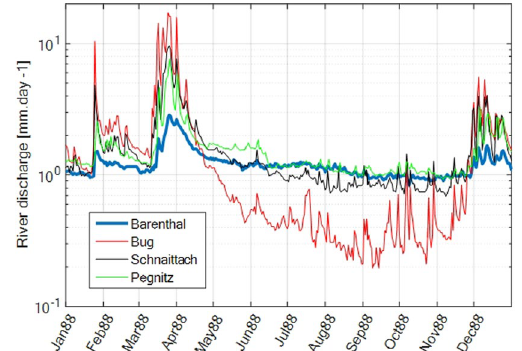
Figure 13. River discharge data for four discharge stations, for year 1988. Discharge can vary over several orders of magnitude, highlighting the integrated behavior of the catchment with respect to boundary conditions (P, E). Discharge variability in Bärenthal (blue line) is the smallest, suggesting a stronger control of groundwater to